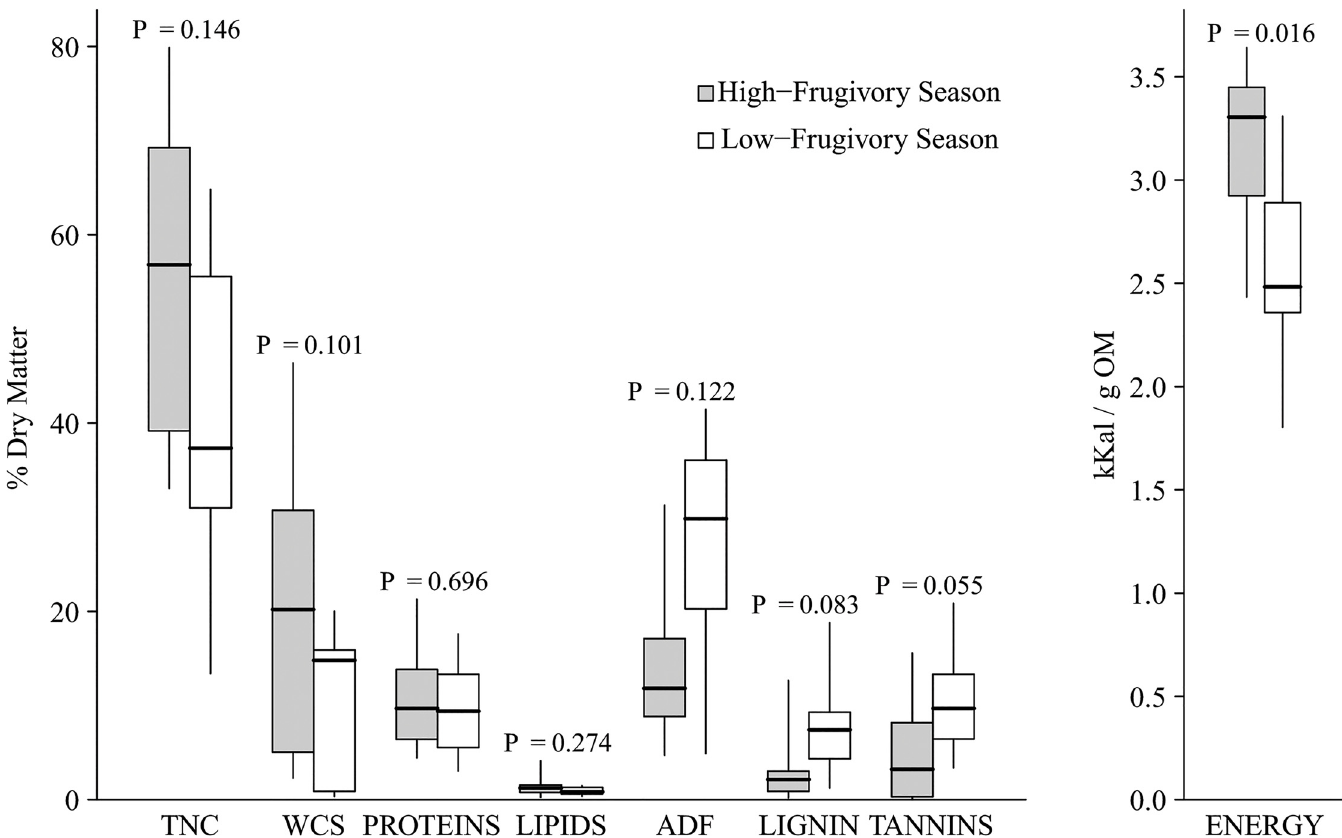
Fig 2. Seasonal variation in median nutritional and chemical composition of important foods (see text for definition) consumed exclusively in one of the two seasons (DM: dry matter; OM: organic matter; TNC: total non-structural carbohydrates; WCS: water-soluble sugars). Bold vertical lines indicate medians; boxes show the first and third quartiles, vertical lines the percentiles 2.5 and 97.5% and laying crosses denote the minimum and maximum. Numbers on the top of the graph denote the sample